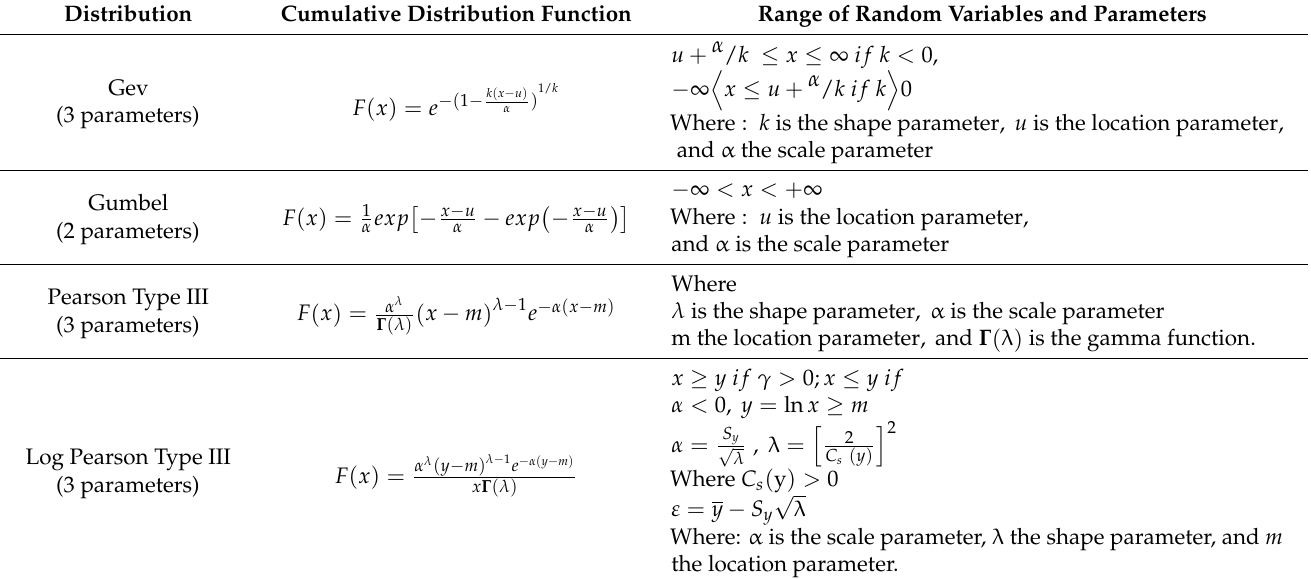
Table 2. Cumulative distribution functions used in the